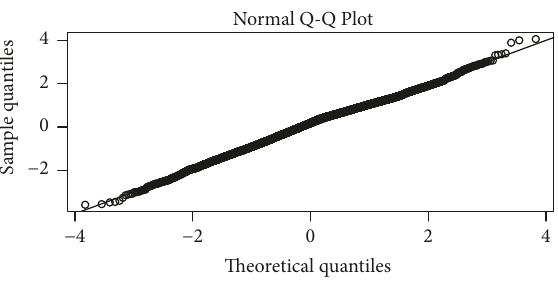
Figure 7: Simulated rainfall and observed rainfall.